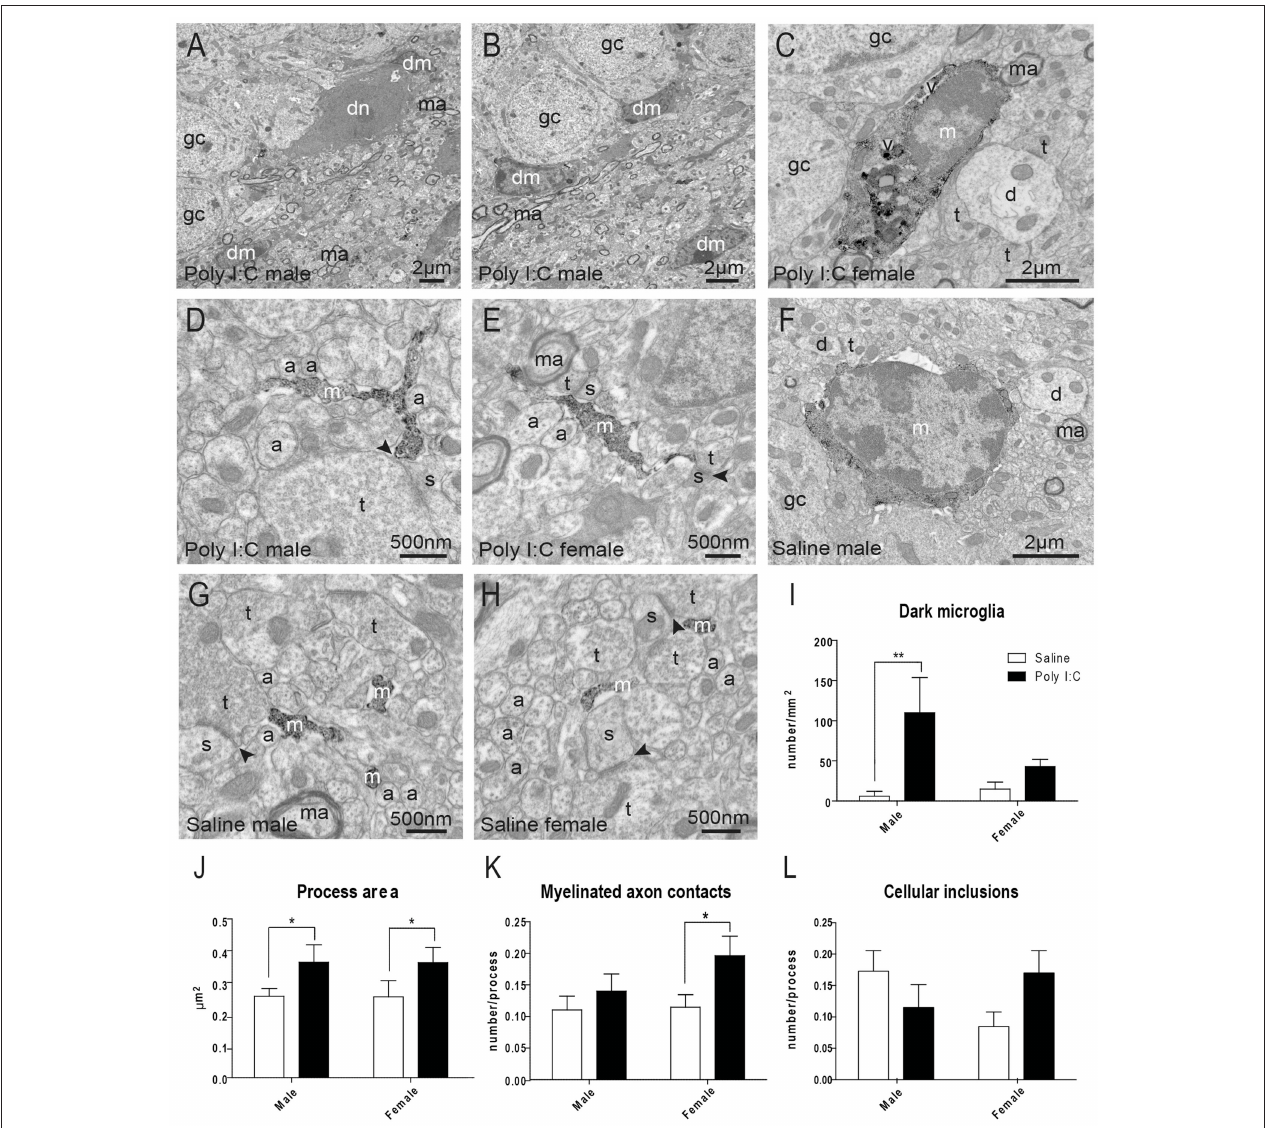
FIGURE 2 | Effects of Poly I:C on microglial ultrastructure in hippocampal DG. (A–E) Examples of cell bodies and processes from dark microglia (dm) vs. typical microglia (m) that show strong immunoreactivity for IBA1 and directly contact dark neurons (dn) with features of cellular stress. (F–H) Examples of IBA1-stained microglial cell body and processes in saline-exposed offspring of both sexes. (I) Quantification of dark microglia’s density in the polymorphic layer. (J–L) Microglial process area, number of contacts with myelinated axons (ma), and number of cellular inclusions in the polymorphic layer. n = 3 animals (dark microglia) or 224–296 profiles (IBA1-stained processes) in three mice per sex and group. Arrowhead, synaptic cleft; a, unmyelinated axon; d, dendritic spine; gc, granule cell; t, axon terminal; v, vacuole. * p < 0.05, ** p <